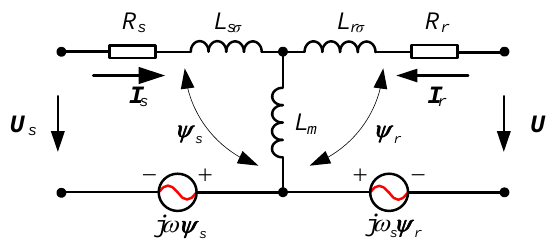
Figure 1. Equivalent circuit of the doubly fed induction generator (DFIG) model.